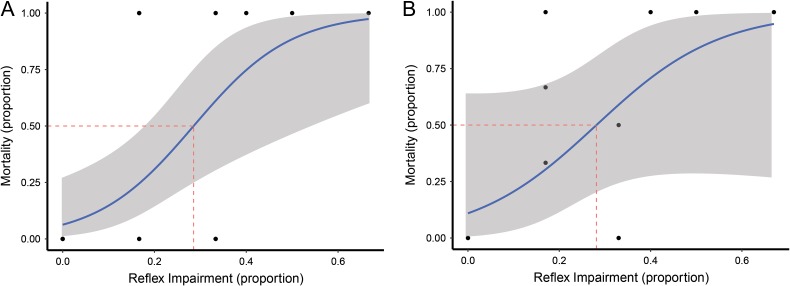
(A) Binomial model fitted to reflex impairment (proportion) and mortality (proportion). Points are individual fish reflex impairment and corresponding mortality (P < 0.001, n = 30). Gray area around fitted line represents 95% confidence interval. Dashed red line represents the median lethal dose of reflex impairment. (B) Generalized linear regression model fitted to average reflex impairment (proportion) for each group and corresponding average group mortality (P = 0.03, n = 12). Gray area around fitted line represents 95% confidence interval. Dashed red line represents the median lethal dose of reflex impairment.